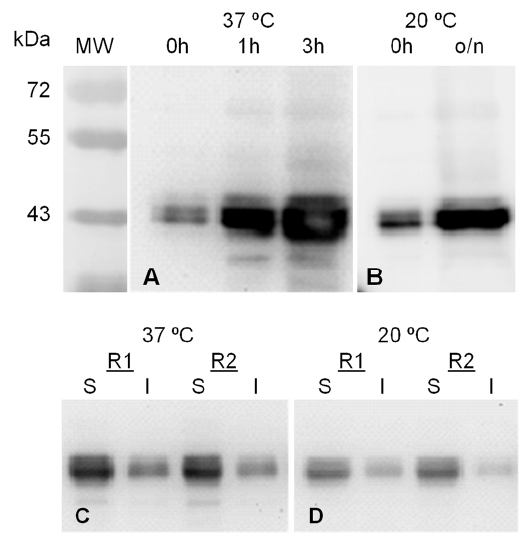
Figure 7. Production (top) and solubility (bottom) of GFP-INT expressed under two different induc- ing conditions. Samples of total cell pellets of induced BL21(DE3)pLysS/pTriEx1.1-GFP-INT cultures at 37 °C for 3 h and o/n at 20 °C (( A , B ), respectively), and their corresponding soluble (S) and insoluble (I) cell fractions ( C , D ) were analyzed by SDS-PAGE and further western-blot developed with an anti-GFP antibody.